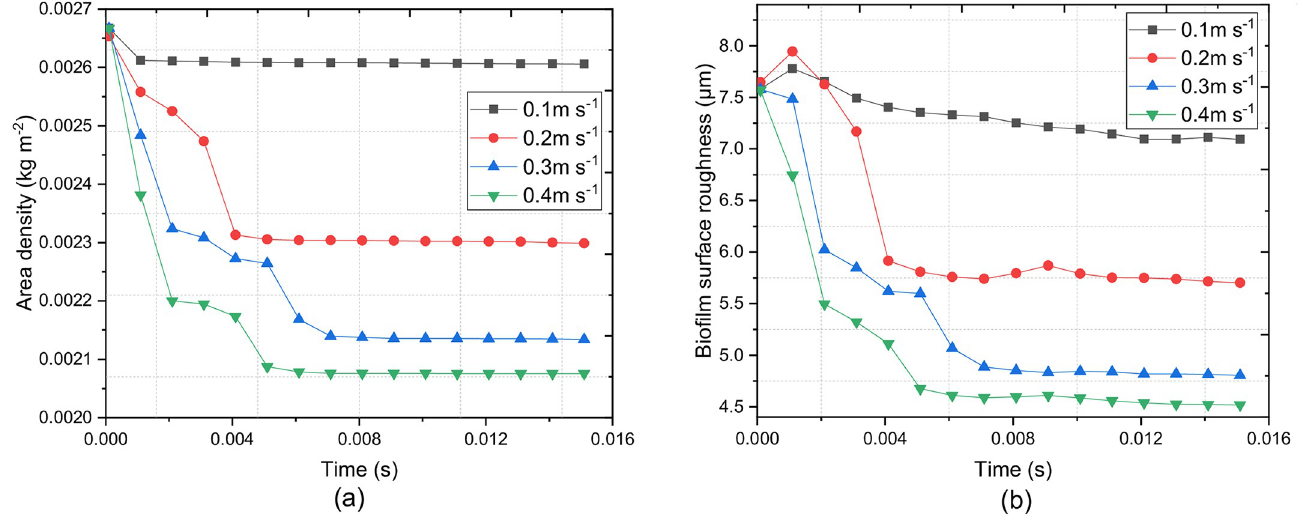
Fig 5. Effect of emergent properties on biofilm detachment. (a) biomasss area density, and (b) biofilm surface roughness.